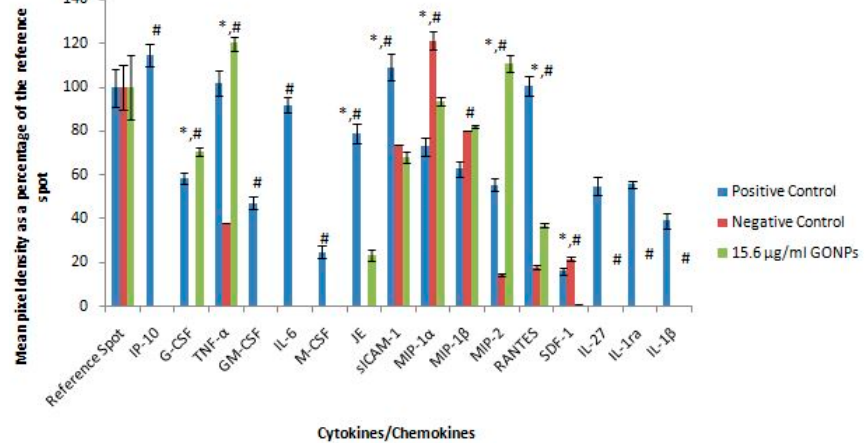
Figure 3. Quantification of cytokines secreted by RAW 264.7 cultures not stimulated with LPS after treatment with medium only or medium containing 15.6 μ g/mL GONPs. Membranes subjected to chromogenic exposure. Data is represented as mean ± SD. Bars marked with symbols indicate significant differences ( p < 0.01). Significance demarcated by: *—significantly different compared to the negative control ( p < 0.001), # —significantly different compared to the positive control ( p < 0.001).